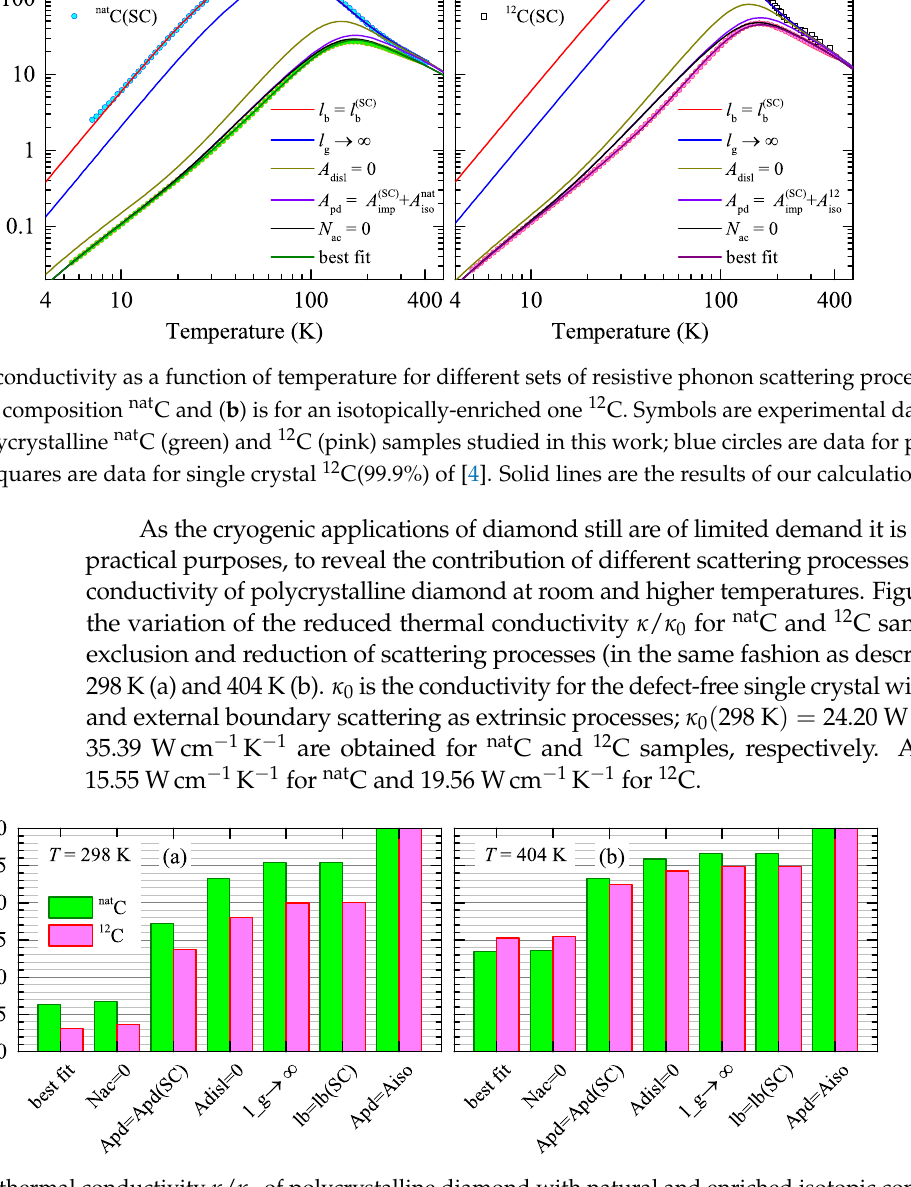
Figure 4. Reduced thermal conductivity κ / κ 0 of polycrystalline diamond with natural and enriched isotopic compositions at ( a ) 298 K and ( b ) 404 K for different sets of scattering processes. The scattering processes are eliminated/suppressed successively as indicated on the x -axis from left to